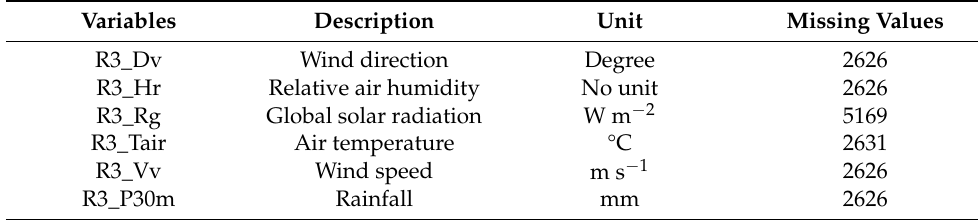
Table 1. Meteorological station data